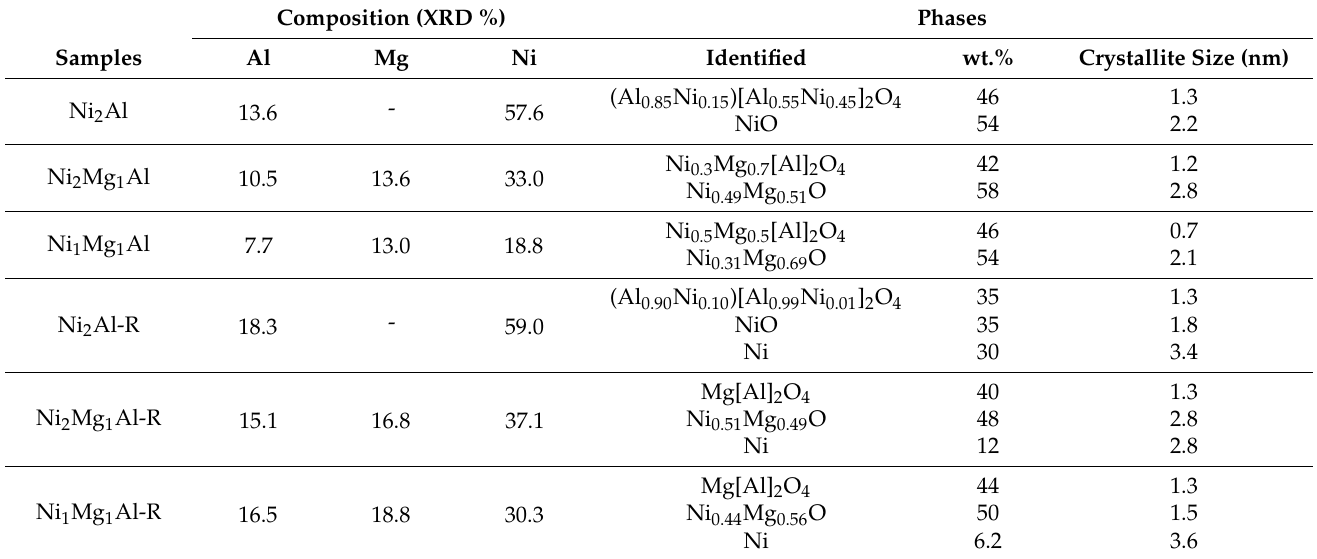
Table 3. Crystalline phases detected and average crystallite sizes calculated from the XRD diffraction patterns of the calcined and reduced samples.